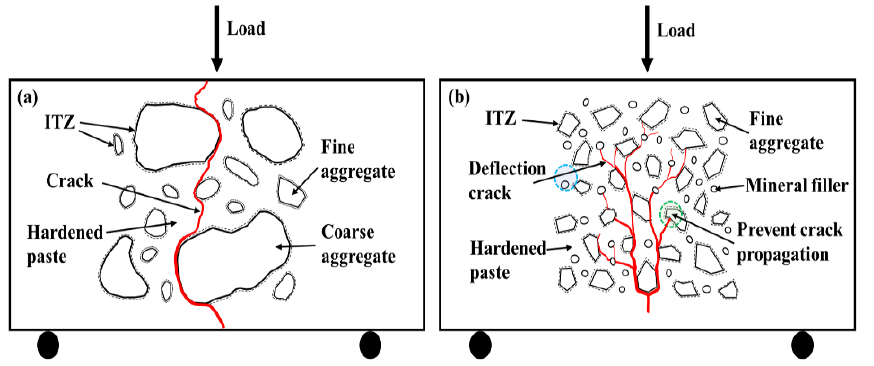
Figure 1. Crack propagation of sand concrete. ( a ) sand concrete with round and coarse aggregate, ( b ) sand concrete with angular and fine